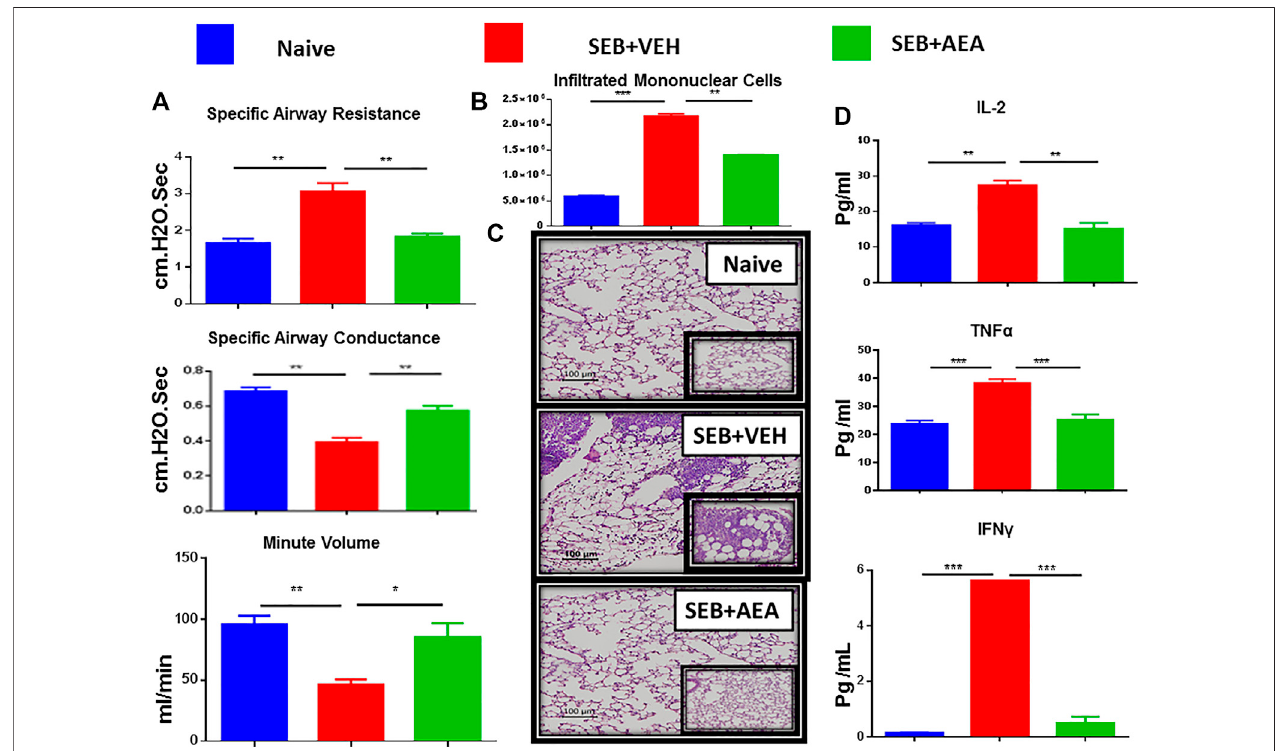
FIGURE 1 | AEA attenuates SEB-induced ALI in mice. Mice were exposed to SEB intra-nasally with a single dose of 50 µg/mouse on day 0. On days-1, 0 and 1, AEA or VEH was given into these mice i. p at a dose of 40 mg/kg body weight. Mice were euthanized on day 2 for various studies. (A) Showing clinical functions of the lung including Speci fi c Airways Resistance (sRAW), Speci fi c Airways Conductance (sGAW), and Minute per Volume (MV). (B) Comparison between the groups for the totalnumber ofMononuclearCellsisolatedfromthelungs. (C) RepresentativeimagesofhistopathologicalH&Estainingofexcisedlungtissue(20Xmagni fi cation). (D) MeasurementofcytokinesIL2, IL6, and TNF α intheserum.Fivemice ineach group wereused and thedatacon fi rmedinthree independentexperiments. * p ≤ 0.05, ** p ≤ 0. 01, *** p ≤ 0.